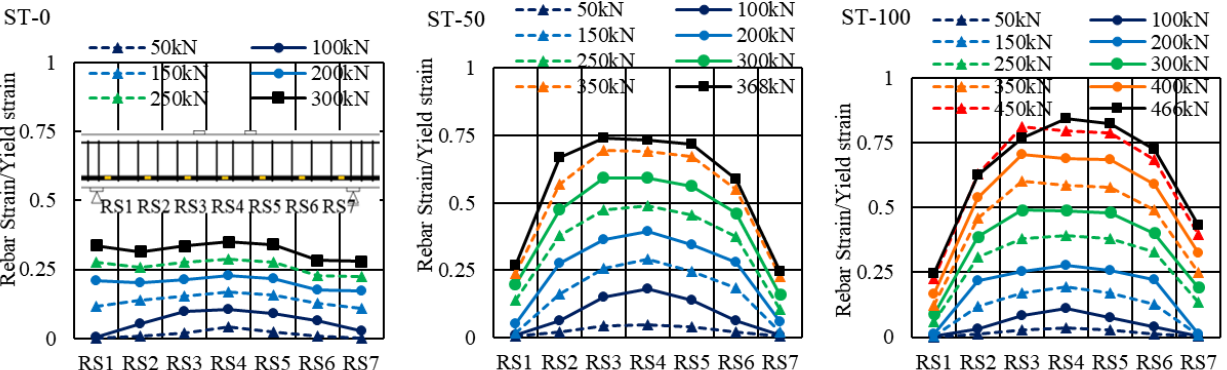
Figure 6. Main rebar strain distribution (ST series).